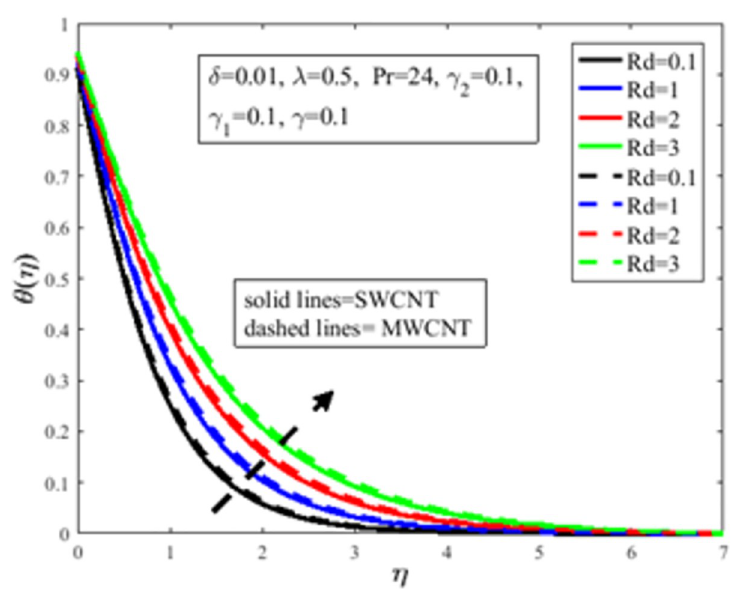
Fig 11. Effect of Rd on θ ( η ).